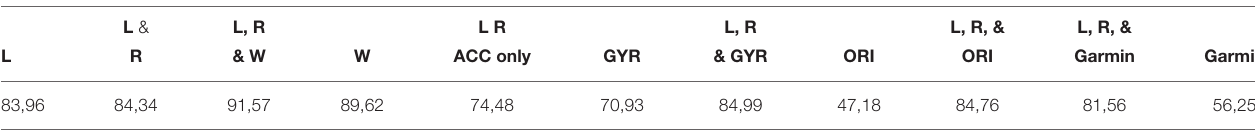
TABLE 7 | Accuracy with different sensor combinations using Bagging and 100 Decision trees.